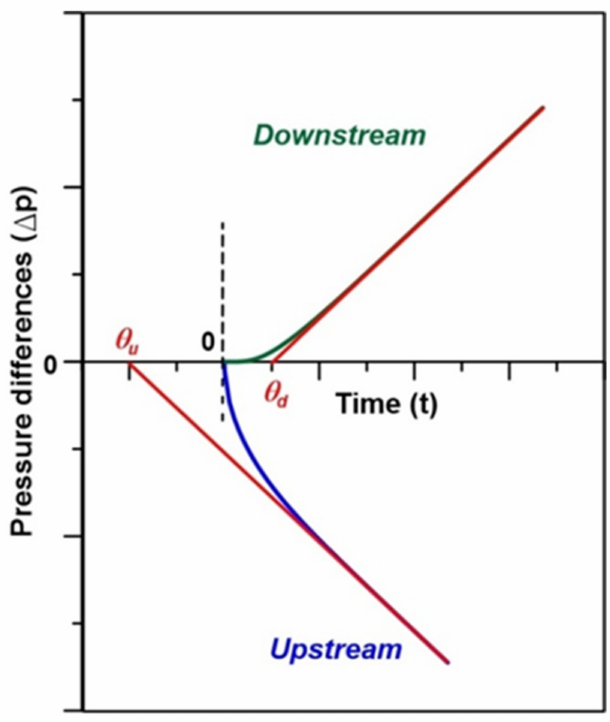
Figure 1. Progress of dynamic gas permeation experiment based on the pressure rise downstream (top curve) and pressure decay upstream (bottom figure) [26]. Reprinted with permission from Ref. [20]. 2020,